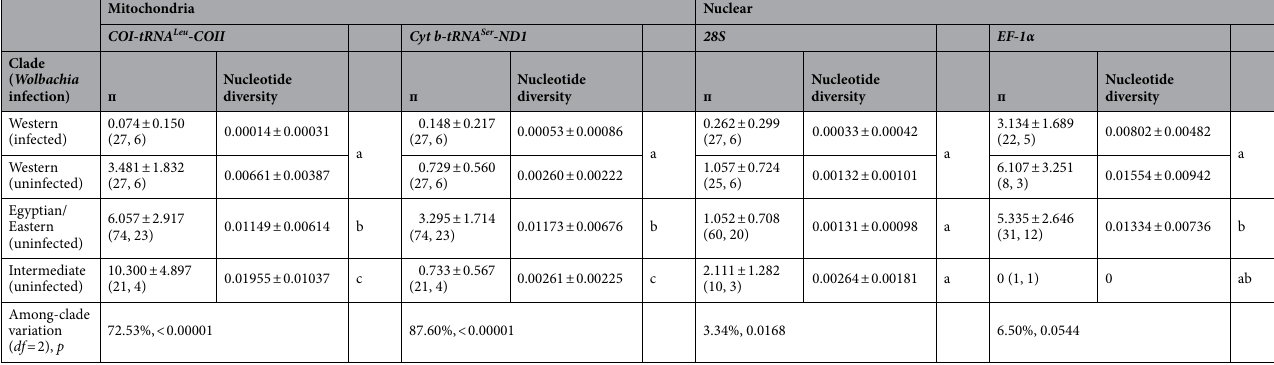
Table 2. Mitochondrial and nuclear genetic diversity of the two clades (the Western and the Egyptian/ Eastern) and the intermediate clades in Hypera postica . п: mean number of pairwise differences; nucleotide diversity (average over loci) (mean ± SD). The genetic distance was calculated based on pairwise differences. Numbers in parentheses are sample sizes (pooled number of individuals, number of populations). The same letters within each column (gene segment) indicate no significant difference between clades ( p > 0.01). For population-wise mitochondrial and nuclear diversities and distances, see Supplementary Tables S1 and S2.